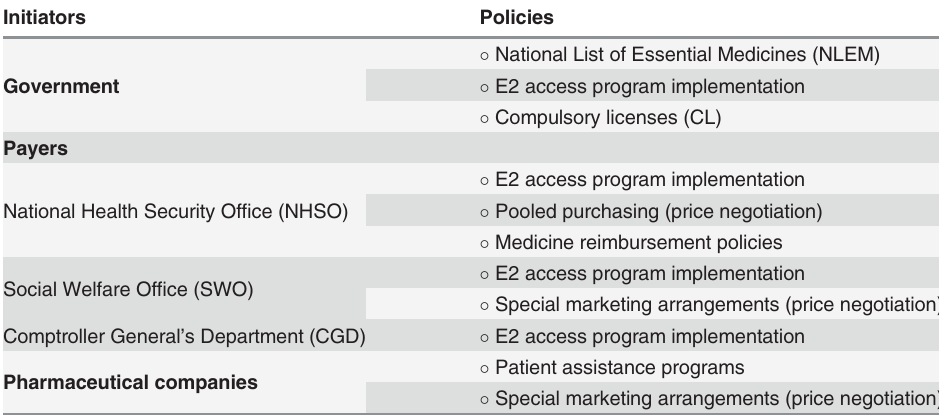
Table 2. Summary of